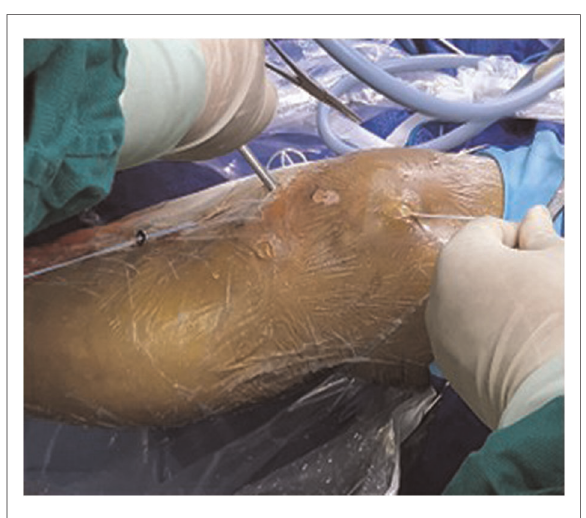
FIGURE 5 The assistant pulls the white cord in order to pull the button plate out through the hole.